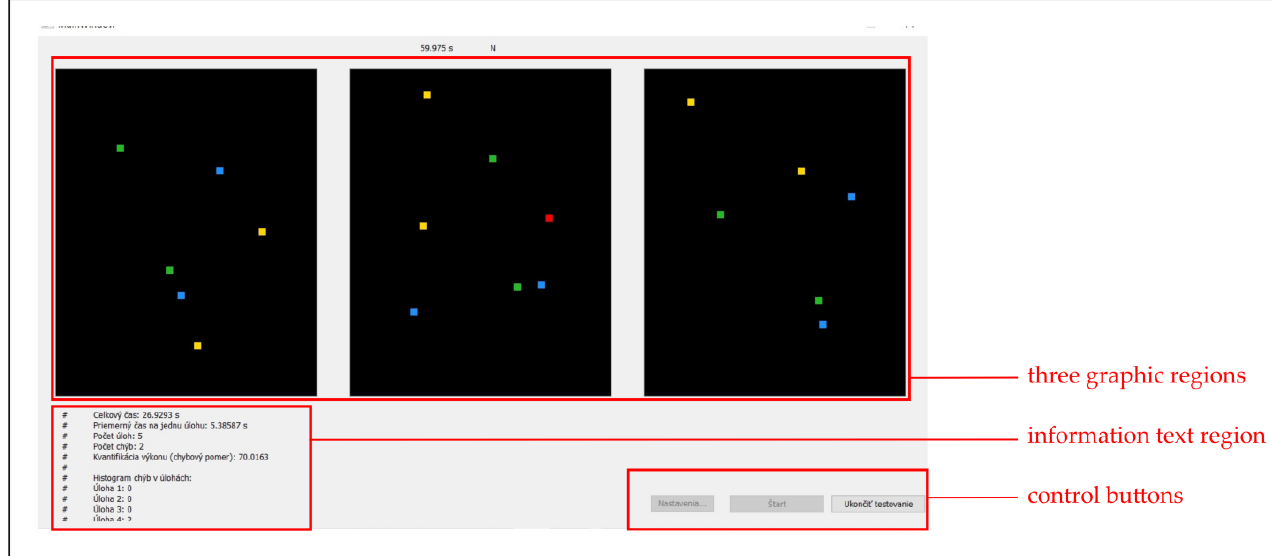
Figure 5. Main window of the application of the testing device.